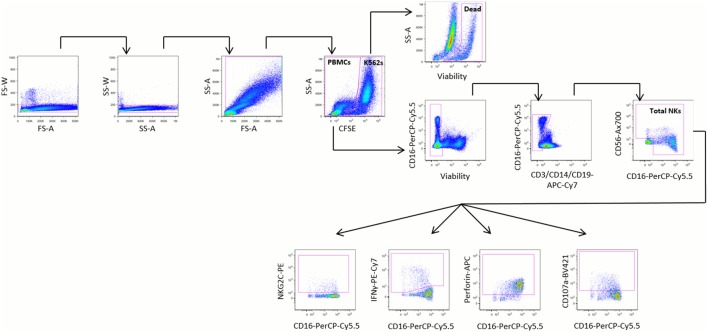
Representative gating strategy. Peripheral blood mononuclear cells (PBMCs) were stimulated for 20 h at a 5:1 ratio with K562 cells and stained with the monoclonal antibodies shown. PBMCs were identified by sequentially gating out doublets, debris, and carboxyfluorescein succinimidyl ester (CFSE)-stained K562 cells. Dead K562 cells were defined as CFSE+ZY+ cells. Natural killer (NK) cells were identified from PBMCs by gating out non-viable cells, then gating on cells negative for CD3, CD14, and CD19 and positive for CD16 and/or CD56. The relative proportions of NK cells expressing NKG2C, interferon (IFN)γ, perforin, and CD107a were identified among all NK cells, CD16− NK cells, and CD16+ NK cells.